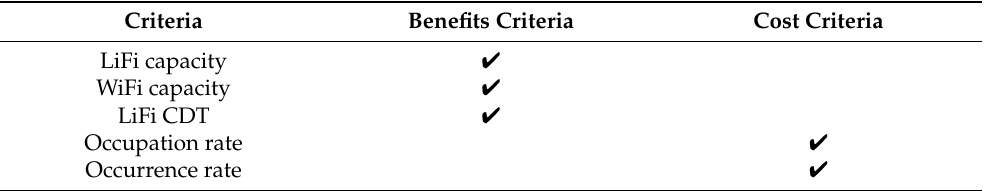
Table 8. Benefit and cost criteria